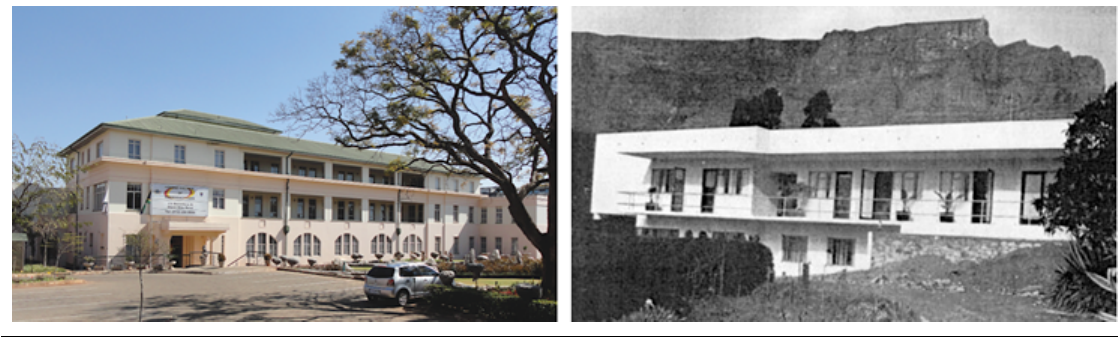
Figure 5. Two maternity homes developed by community organisations: the Moedersbond in Pretoria (left) and the Leeuwendal Maternity Home in Cape Town (right). The former is now used as a training institute for ambulance personnel, while the latter has been demolished (Source: author (left); Van Graan, 2011